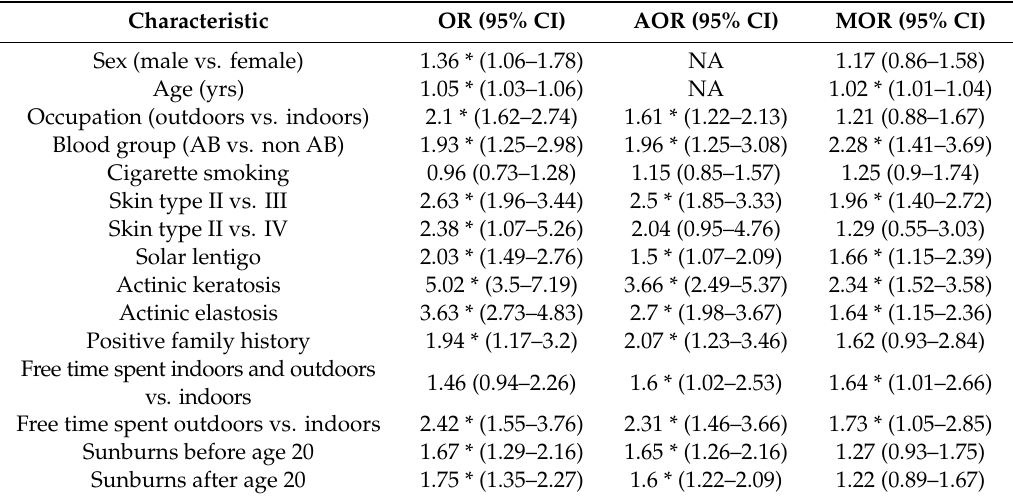
Table 2. Results of logistic regression for nonmelanoma skin cancers (NMSCs) outcomes.